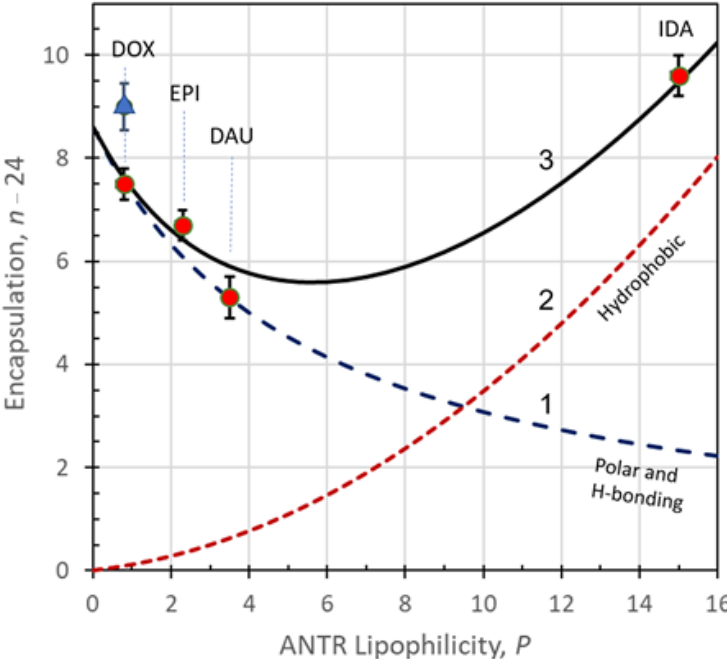
Figure 8. Model calculations for ANTR drugs encapsulation in APO nanocage carriers: (1) contribution of dipolar and hydrogen binding, (2) contribution of hydrophobic interactions, (3) sum of contributions (1) and (2); experimental points are shown with markers: circles (this work), triangle (according to